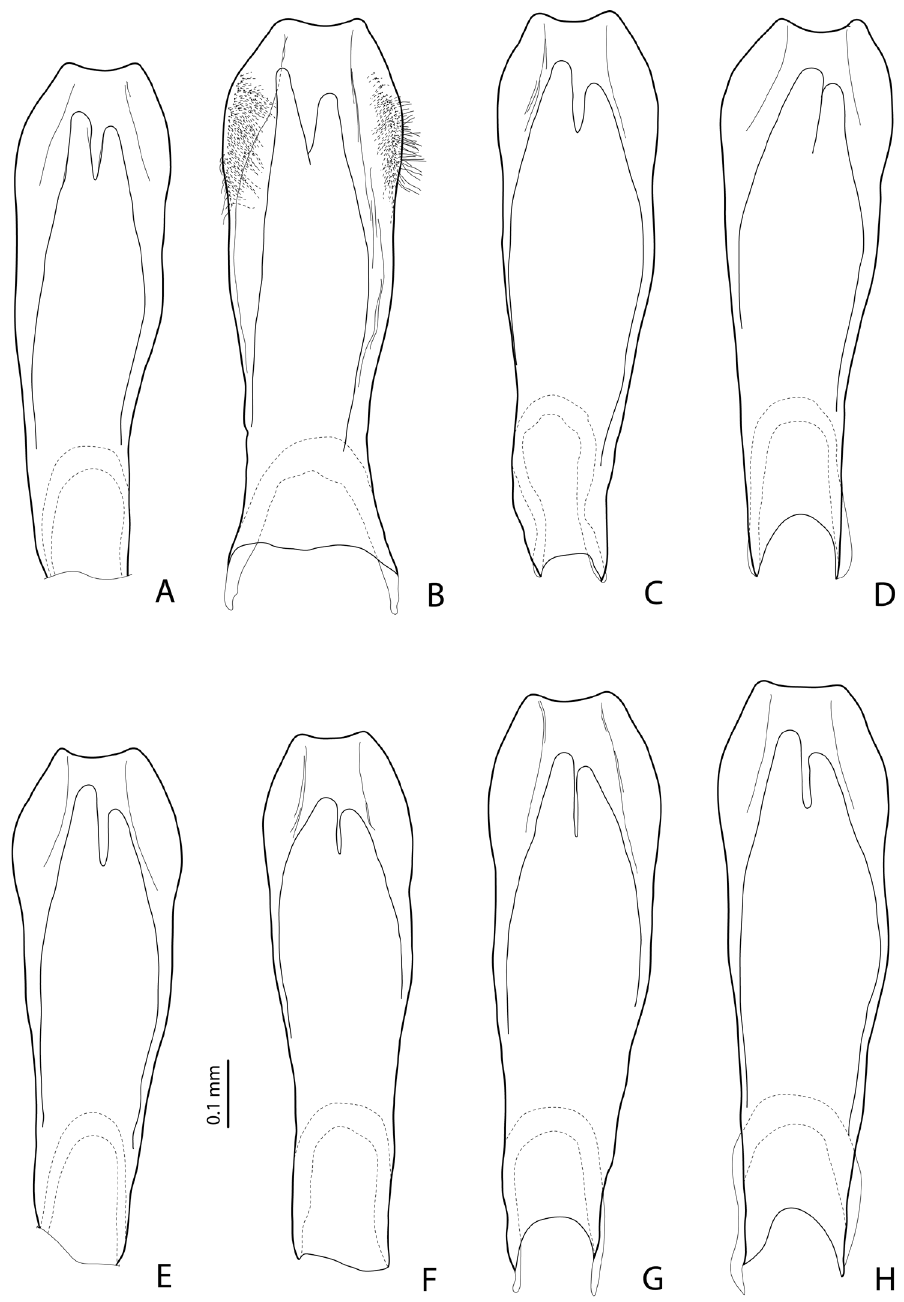
Figure 11. Exocelina damantiensis (Balke, 1998), median lobe in ventral view, setae are not shown A IN, Papua, Bime-Calab, 16, paratype of E. rivulus (Balke, 1998) B IN, Papua, Angguruk, 32, paratype of E. rivulus C, D PNG, Sandaun, Mianmin area, PNG236 and Wara-Uk, WB16 E, F PNG, Western Prov- ince, Tabubil, PNG181 G PNG, Enga, PNG128 H PNG, WHL,